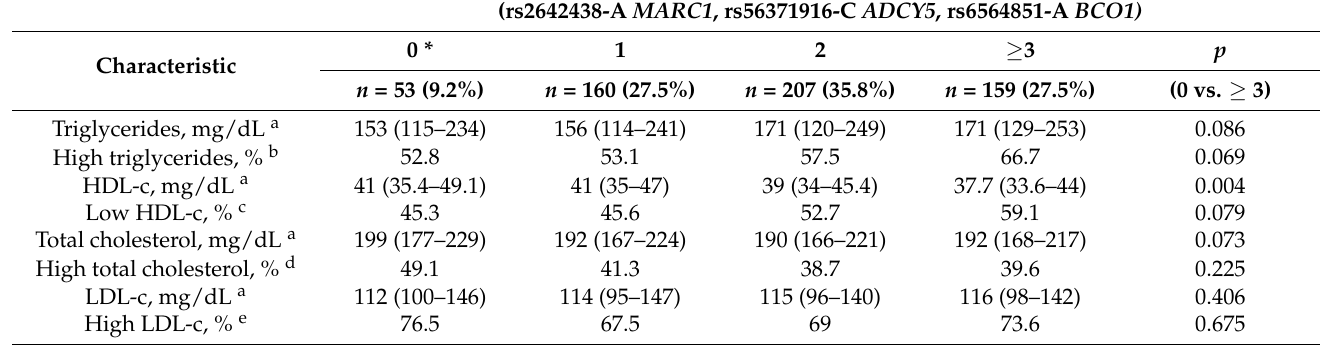
Table 4. Comparison of the lipid profile according to the number of risk alleles in Mexican adult